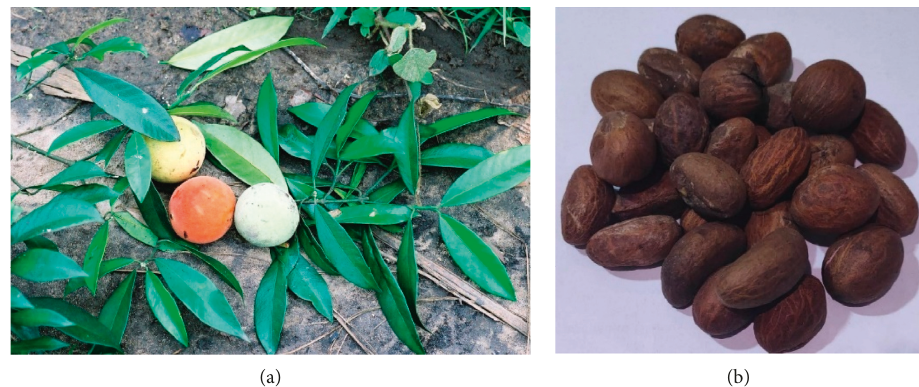
Figure 1: Leaf and fruits (a) [7] and seeds (b) of Garcinia kola